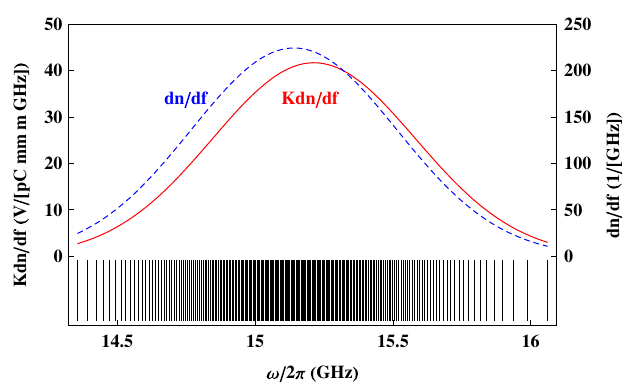
FIG. 11. (Color) Smoothed undamped kick factor weighted density function Kdn=df (in red), mode density function dn=df (in blue and dashed), and the location of individual modes (indicated by vertical black lines).